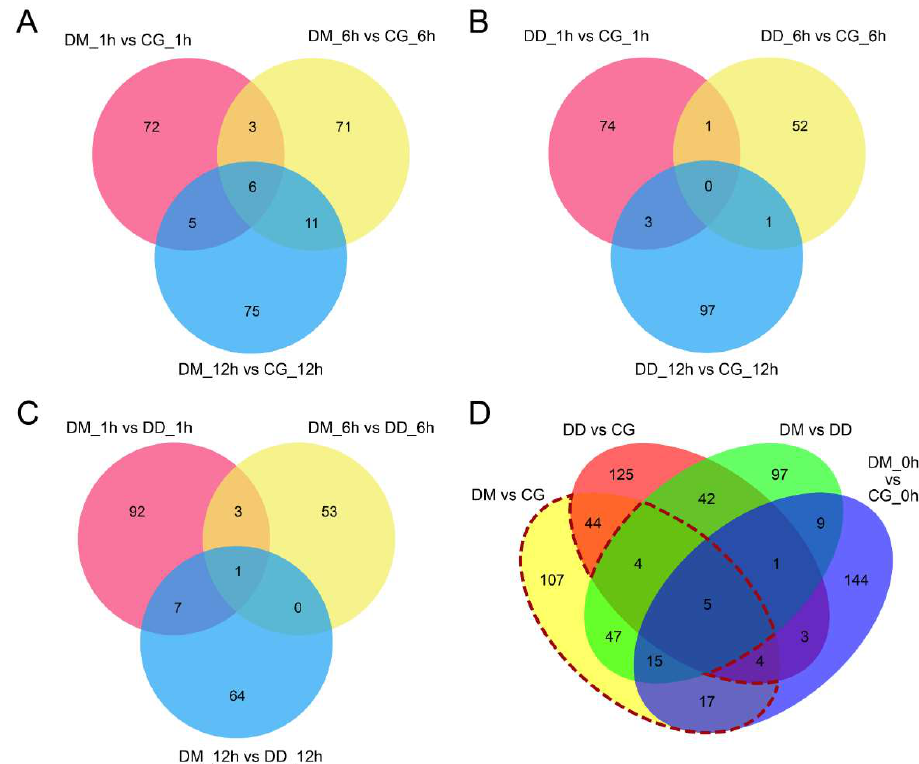
Figure 2. Identification of drought memory-related miRNAs. ( A – C ) Venn diagrams of significantly different expressed miRNAs amongst CG, DD, and DM groups ( D ) Identification of drought memory-related miRNAs according to miRNA sequence data. (DM vs. CG) vs. (DD vs. CG) revealed 186 drought memory-specific miRNAs and 57 shared miRNAs. Fifty-seven common miRNAs were searched in the DM vs. DD miRNA set, and nine miRNAs were found to be significantly differentially expressed between DM and DD groups. Finally, we obtained 195 candidate drought memory-related miRNAs (inside the dotted red line).